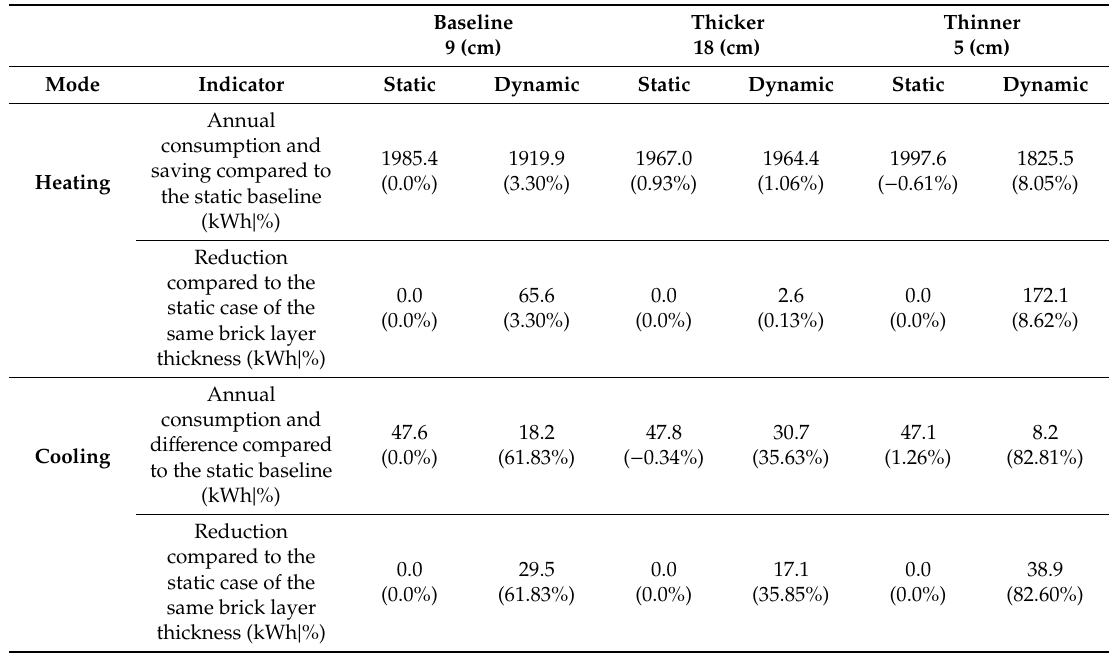
Table 7. Comparison of annual heating and cooling energy consumption for various thicknesses of the exterior brick layer for the walls of the prototypical Belgian